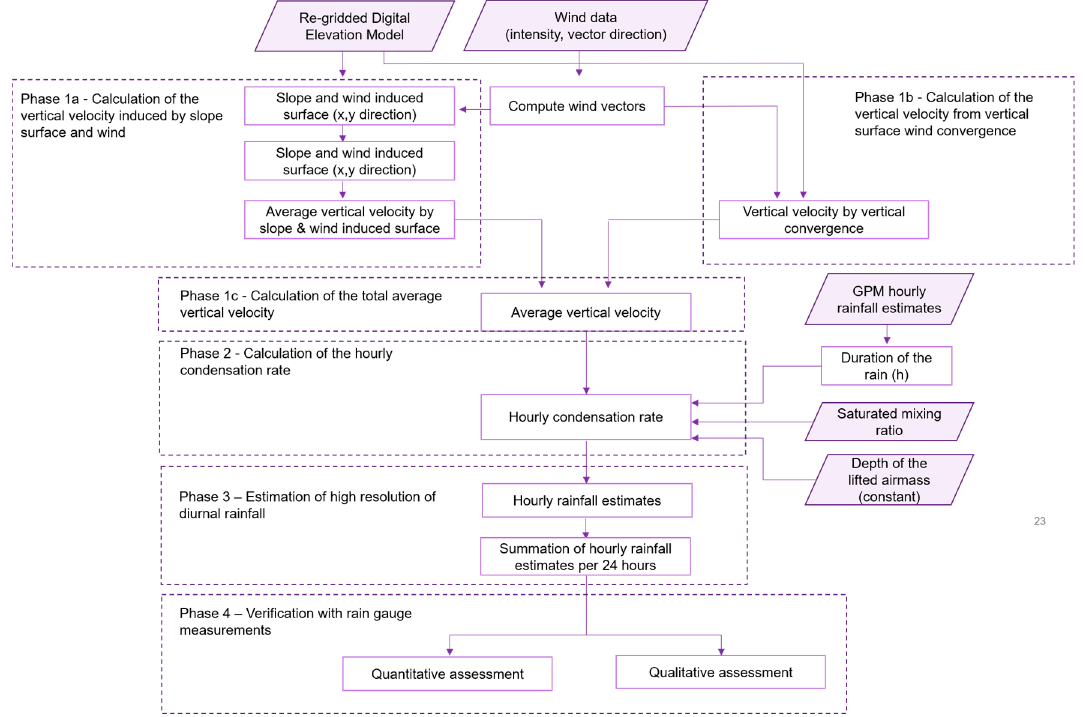
Figure 5. Schematic flow of methodology.